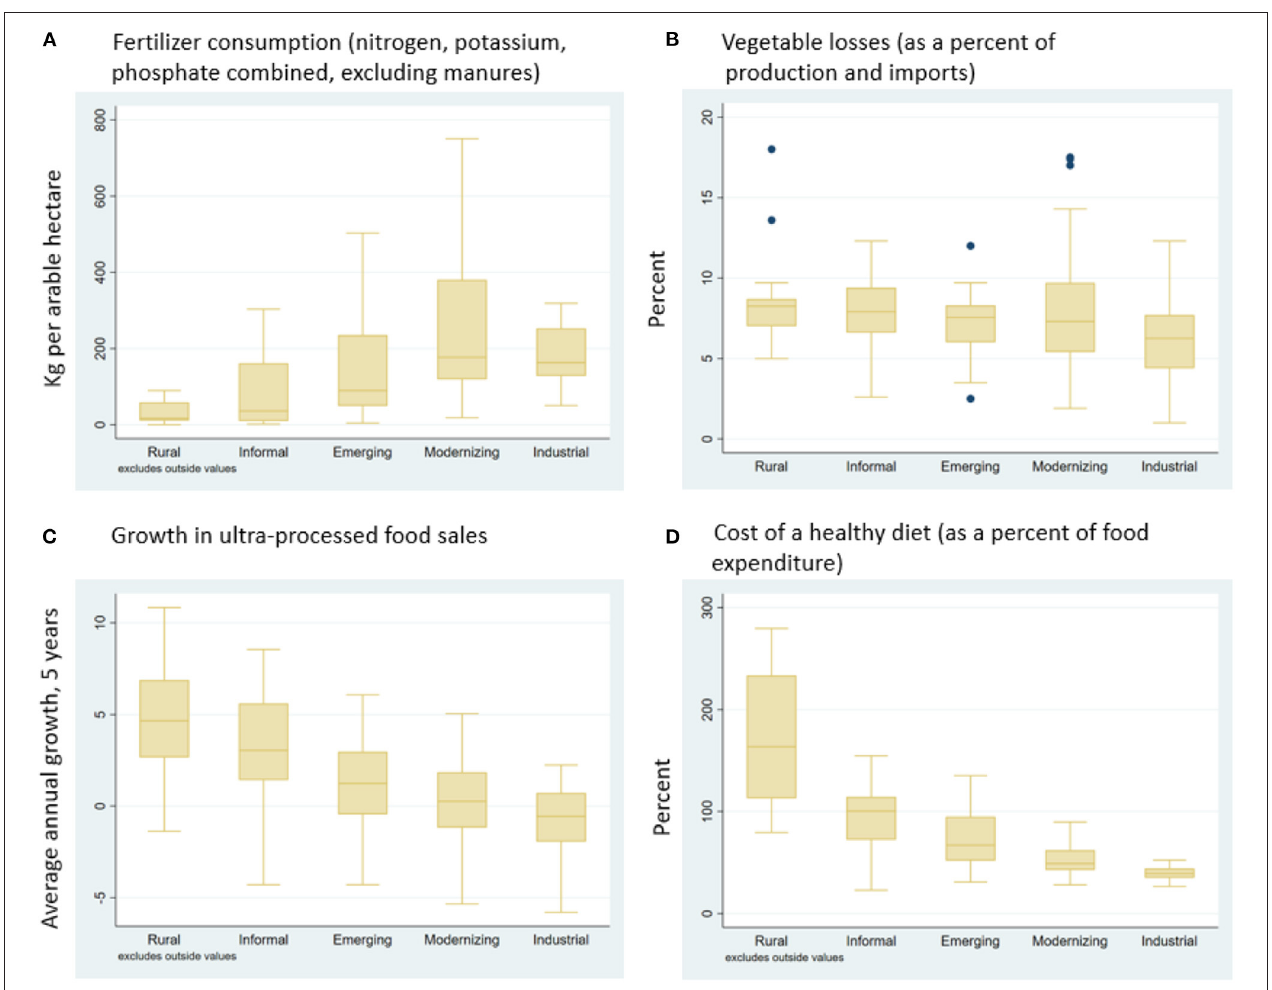
FIGURE 4 | Comparison of supply chain and food environment variables across the food system types. Note that outliers are excluded from graphs (A,C,D)